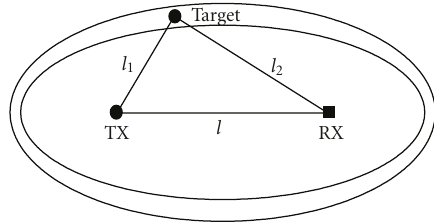
Figure 6: Variable thickness annulus inside which the target is located in presence of imperfect TOA